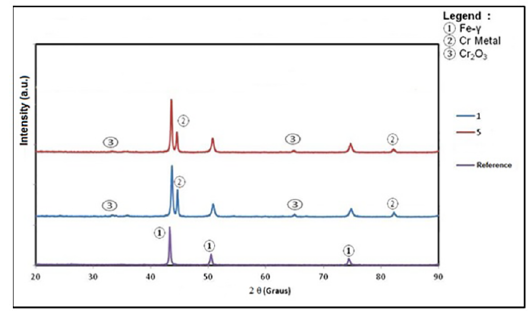
Figure 1. Diffractograms: of the substrate (reference) and of the samples 1 and